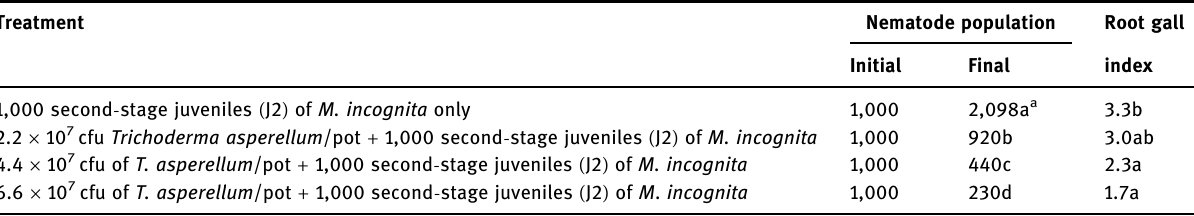
Table 1: E ff ect of treatment on fi nal nematode population and gall index Treatment